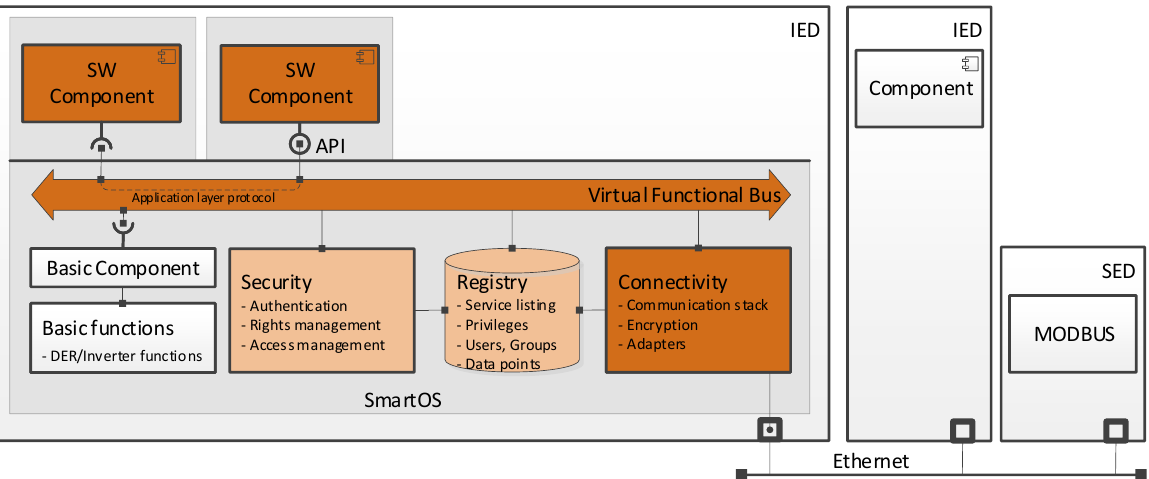
Figure 14. SmartOS components validated in scenario “Generic and Interoperable Communication” (adopted from Reference